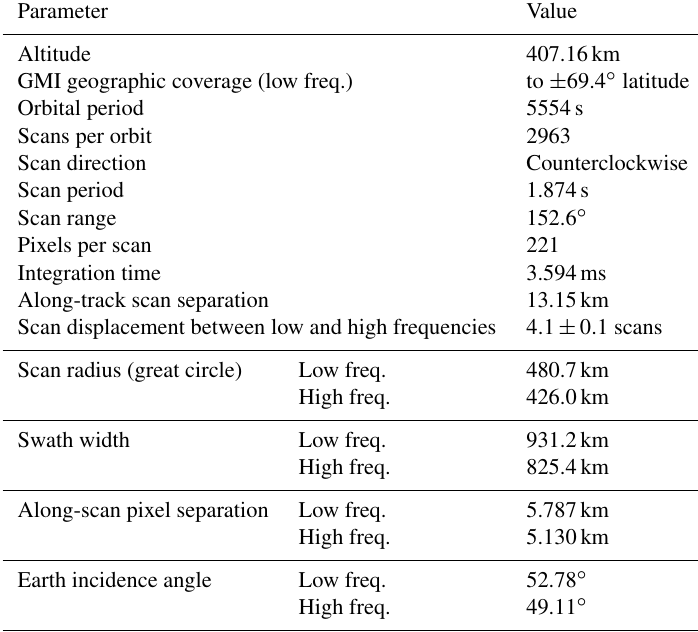
Table 2. Measured and inferred satellite and sensor characteristics determined from actual GMI data so as to construct a self-consistent geometric scan model. These values should be considered typical rather than absolute.